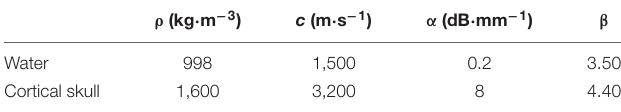
TABLE 1 | Numerical simulation constant parameters.